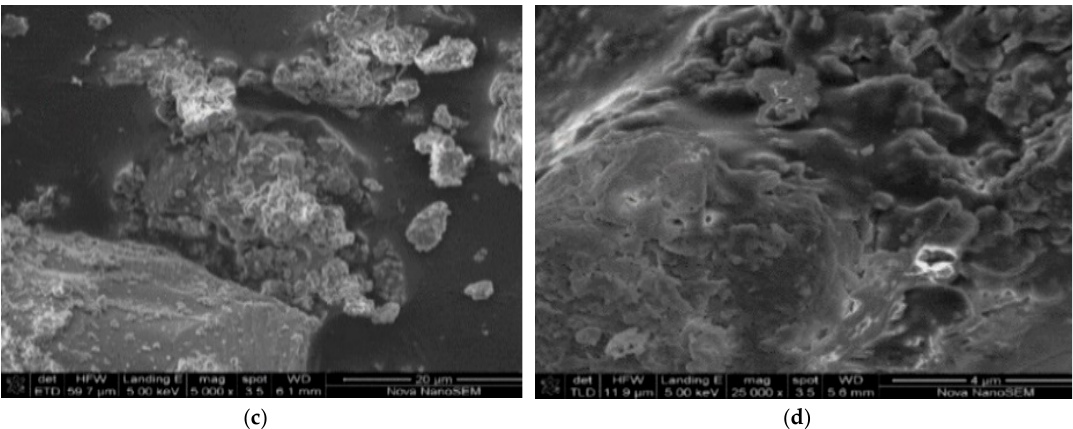
Figure 1. ( a – d) : Scanning electron microscopy (SEM) micrographs of the most mechanochemically activated clay at different magnifications.